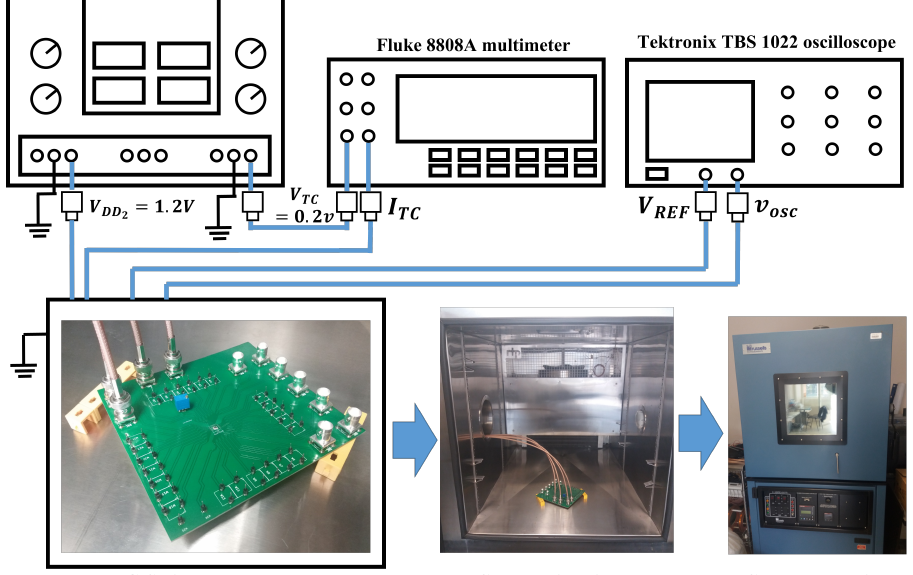
Figure 27. Test-bench of the LF